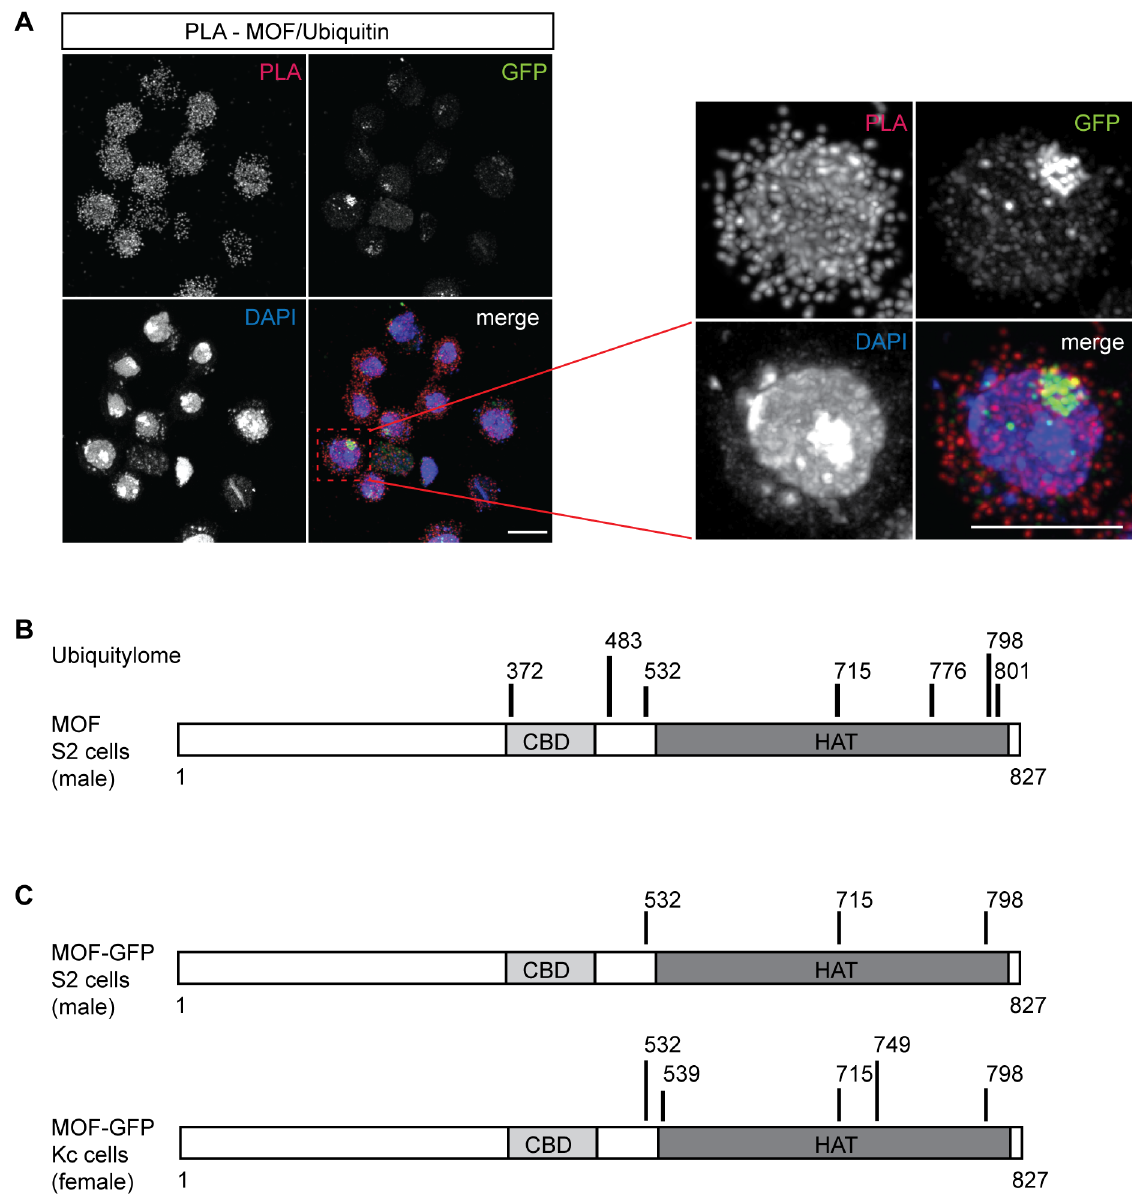
Fig 2. MOF is ubiquitylated in vivo. (A) Detection of MOF ubiquitylationin vivo using proximity ligationassays (PLA). Cell lines stably expressingMSL2-GFP were subjectedto PLA assays with anti-MOF and anti-ubiquitin antibodies.The right panel shows an enlargement of one representative cell from the left panels.‘Merge’ shows an overlayof the PLA signal (red, ubiquitylated MOF), the anti-GFP signal (enrichment of MSL2-GFP at the X chromosome territory, green) and counterstaining of DNA with DAPI (blue). Scale bars represent 10 μ m. (B) The ubiquitylome of MOF in S2 cells. S2 protein extracts were digestedwith trypsin and ubiquitylated peptides were immunoprecipitatedwith a di-glycine antibody and identified by LC-MS/MS. A schematic summary of ubiquitylation sites are presented. Black bars indicate ubiquitylated lysines on MOF. CBD: chromobarrel domain, HAT: histone acetyltransferase domain. One biological replicateis shown. (C) Summary of ubiquitylation sites on overexpressed MOF-GFP. MOF-GFP was affinity-purified from stable S2 (male) and Kc (female) overexpression lines and ubiquitylated lysines (back bars) were identified by mass spectrometry. S2 cells were analyzedin four biologicalreplicates, for Kc cells two replicates were